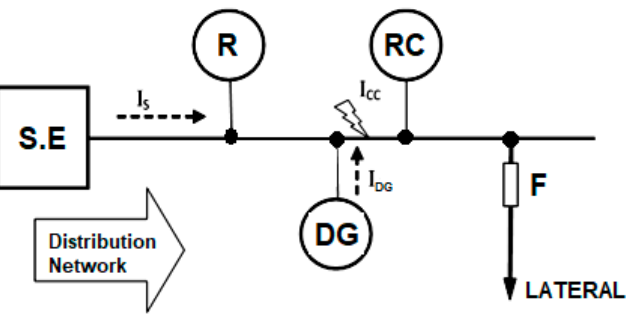
Figure 3. Sketch of a short circuit downstream of DG.